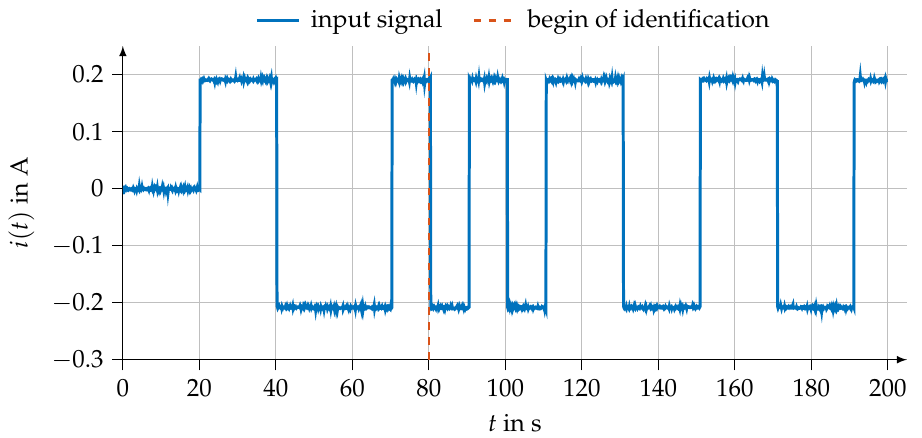
Figure 5. Input current measured with the digital multimeter 34410A and used as the input signal for the parameter and order identification of the fractional battery model (44).